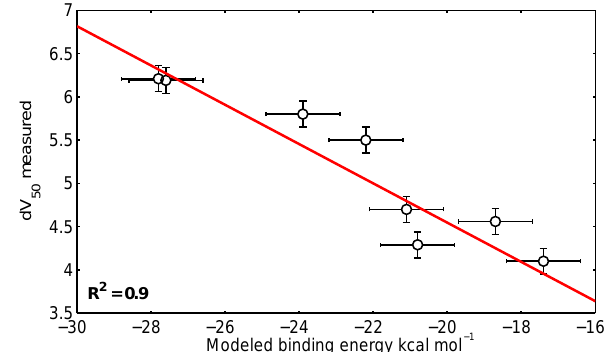
Figure 5. Application of the collision limit to secondary organic aerosol concentration utilizing a FIGAERO inlet. The application of the collision limit allows conversion of detected signals to a lower limit mass loading; despite this assumption, the mass load- ing explains a large fraction of SOA ( ∼ 50%) and is highly corre- lated with total organic aerosol mass concentrations measured by an AMS ( R SOAS = 0 . 82 and R BEACC = 0 . 76). The lower correla- tion for BAECC is likely because of lower total organic and perhaps because the AMS was located on the ground, while the FIGAERO was located at the top of a 35m tower. To attempt to reduce this po- tential bias, only data points during daytime are plotted for BAECC as surface inversions (below the tower) were regularly observed at